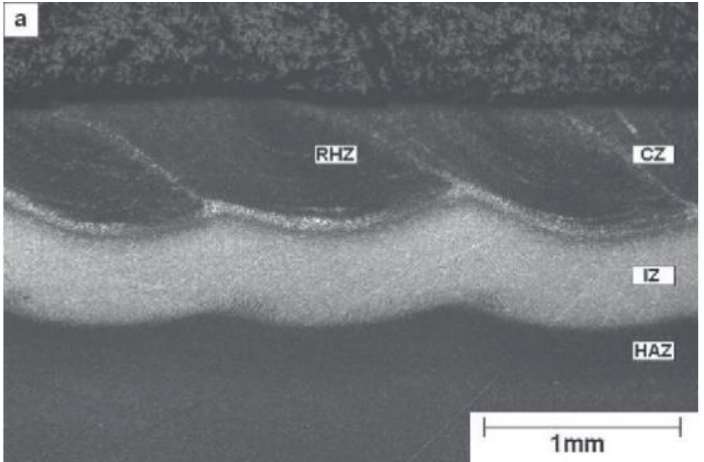
Figure 12. Optical micrograph presenting different zones during LC of CPM 10V on Vanadis 4 Extra tool steel plates (CZ: Clad zone, IZ: Interface zone, HAZ: Heat-affected zone, RHZ: Reheated zone). Reproduced with permission from [24]. Copyright Elsevier, 2011.